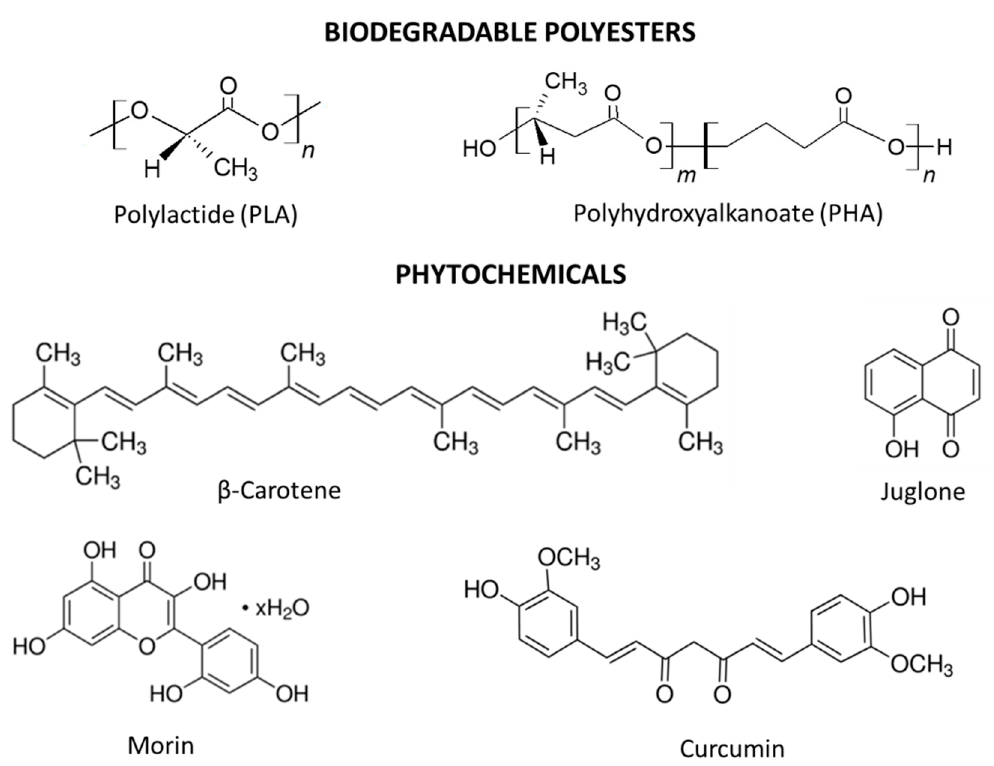
Figure 1. Structure of biodegradable polyesters and phytochemicals.